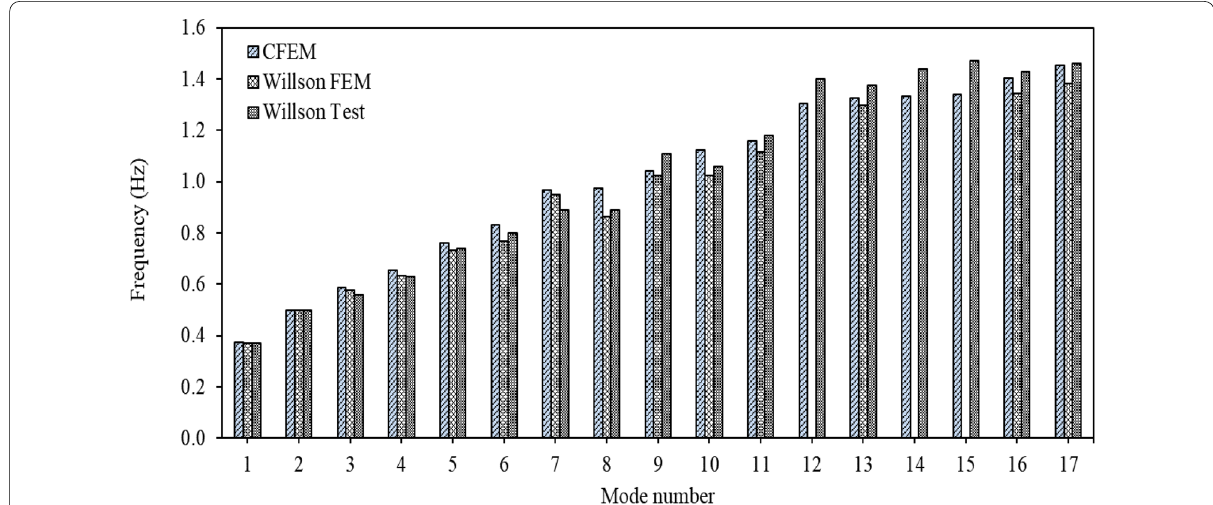
Fig. 5 Modal frequencies from CFEM, Wilson FEM and Wilson test.